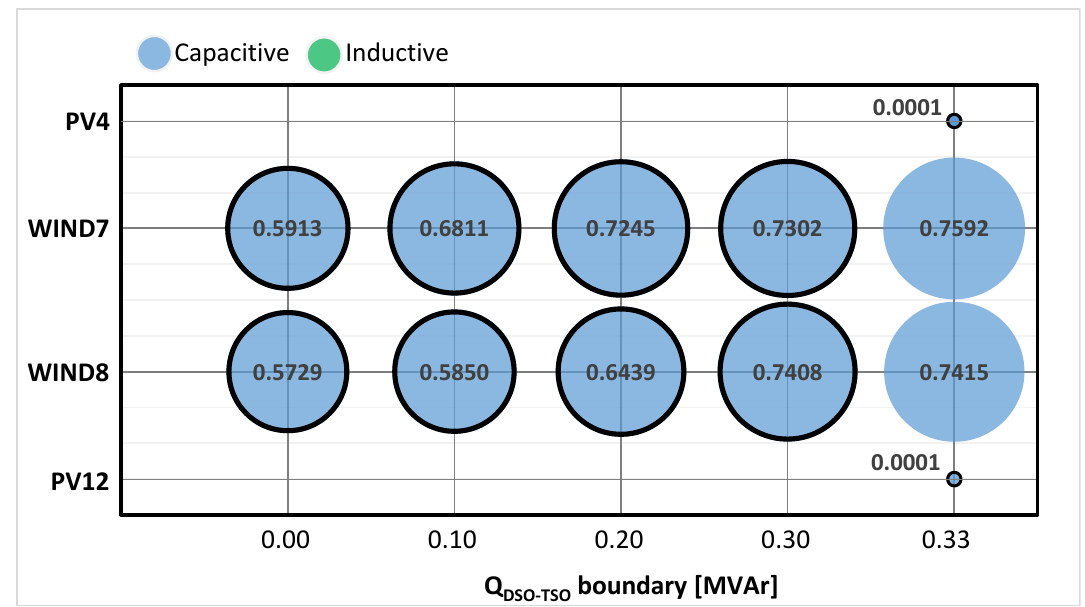
Figure 12. Reactive power scheduled for increasing TSO Q capacitive needs.